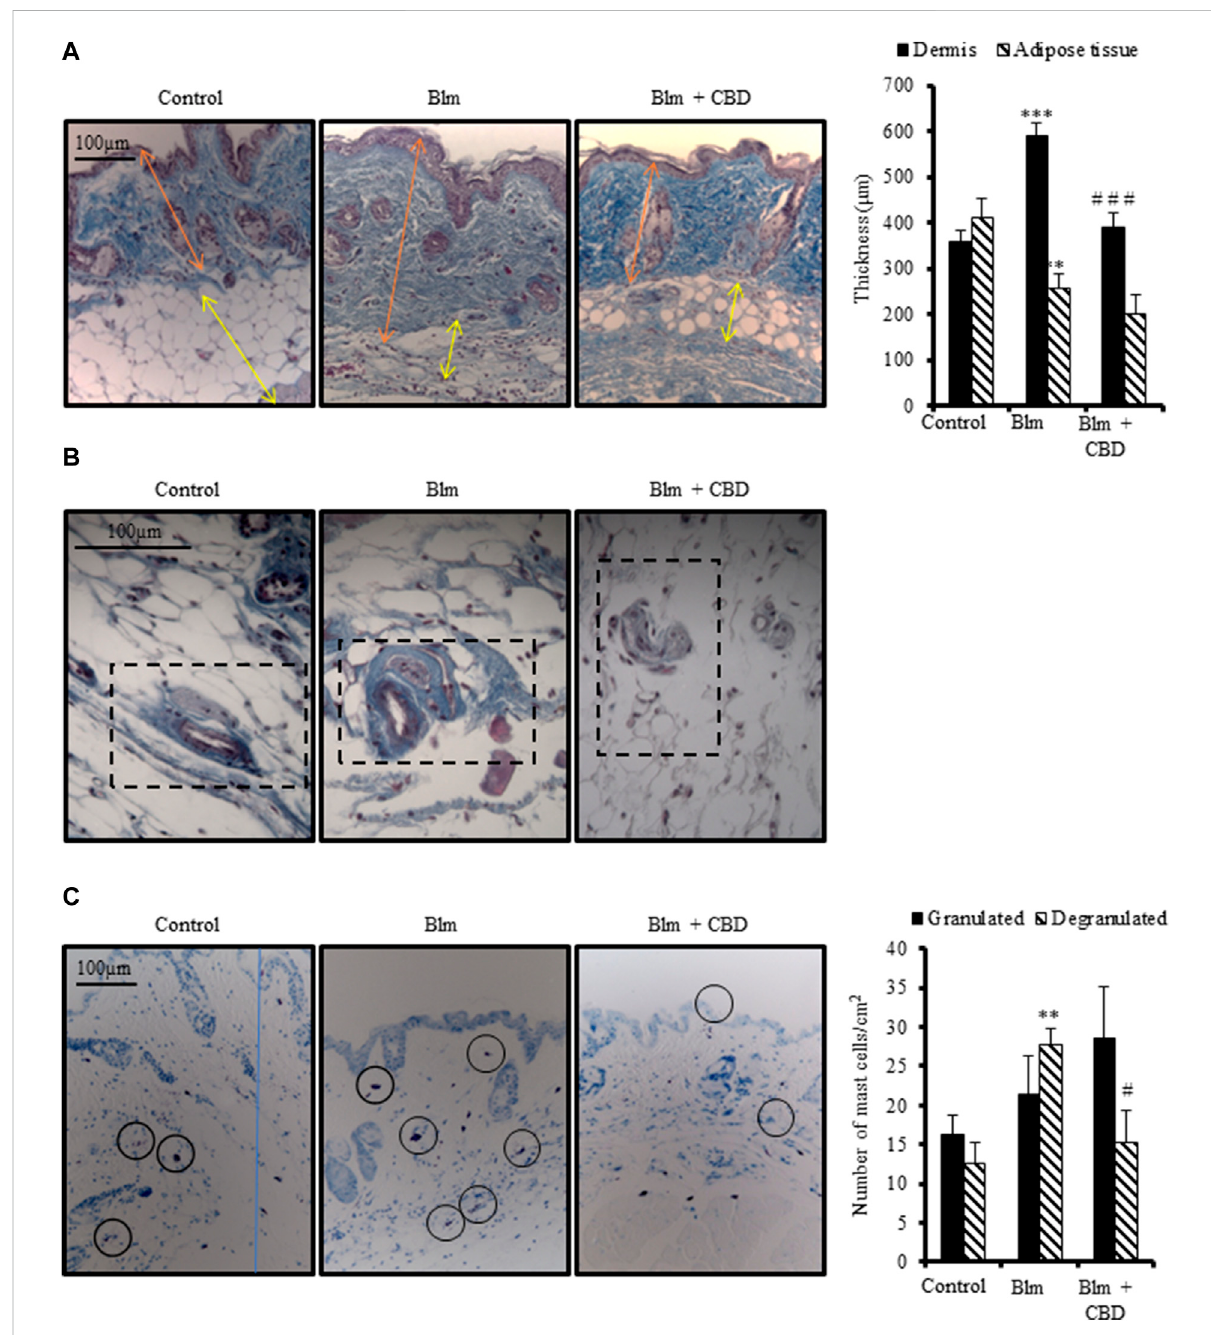
TreatmentwithCBDreducedskin fi brosisdevelopmentinamousemodelofsystemicsclerosis.Skin fi brosiswasinducedbydailysubcutaneous administration of BLM for 3 weeks and mice were treated in parallel with CBD or vehicle i. p. injections (n = 9 mice per group). (A) Representative images of Masson ’ s trichrome stained skin sections and quanti fi cation of dermal and subcutaneous adipose layers thickness. (B) Masson ’ s trichrome staining showing collagen around skin blood vessels. (C) Representative images of toluidine blue stained skin sections showing mast cell degranulation and their corresponding quanti fi cation. Data represent the mean ± SEM. * p < 0.05; *** p < 0.001 vs control mice. # p < 0.05; # # p < 0.01 vs BLM-treated